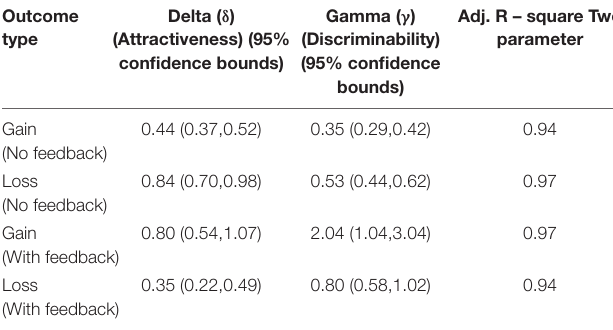
TABLE 4 | Parameter estimates of two-parameter probability weighting function for feedback and no-feedback